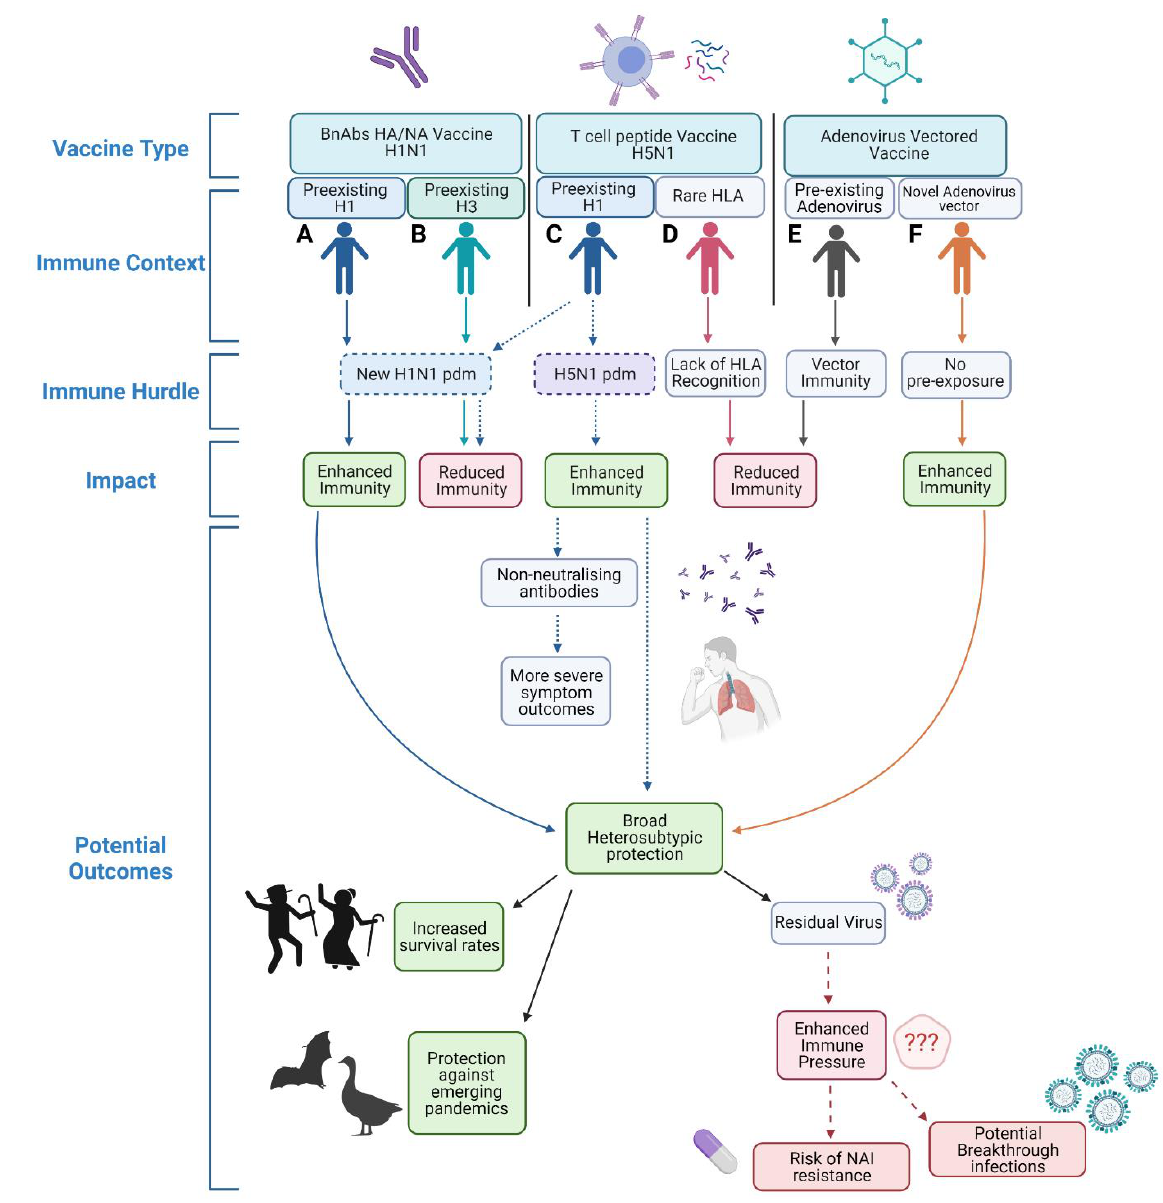
Figure 1. Overview of potential hurdles to varying universal IAV vaccination strategies. Individual ( A ) vaccinated with a H1N1 BnAbs HA/NA vaccine with prior H1 exposure would have enhanced immunity when exposed to a novel H1N1 pdm virus. Conversely, individual ( B ) also vaccinated with a H1N1 BnAbs HA/NA vaccine but with prior H3 exposure may have reduced immunity against the same novel H1N1 pdm virus. After vaccination with a H5N1 T cell peptide vaccine individual with prior H1 immunity ( C ) would have enhanced protection against a homosubtypic H5N1 challenge but may have reduced protection against a novel H1N1 pdm virus. Individual ( D ) who possesses a rarer HLA type may fail to be protected by a T cell peptide vaccine due to lack of T cell recognition. After vaccination with an adenovirus vectored vaccine an individual with prior vector immunity ( E ) would have impartial priming leading to reduced immunity, whereas an individual with no prior adenovirus vector exposure ( F ) would be sufficiently primed. Created in biorender.com.